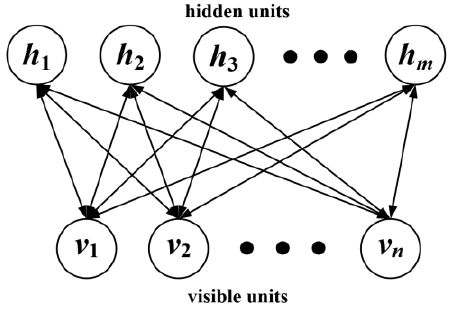
Figure 2. The structure of the RBM.